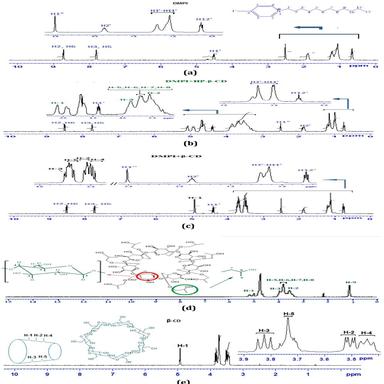
a. FTNMR spectrum of DMPI. b. FTNMR spectrum of DMPI + HP-β-CyD inclusion complex ( 1 H) c. FTNMR spectrum of DMPI + β-CyD inclusion complex ( 1 H) d. FTNMR spectrum of HP-β-CyD e. FTNMR spectrum of HP-β-CyD.